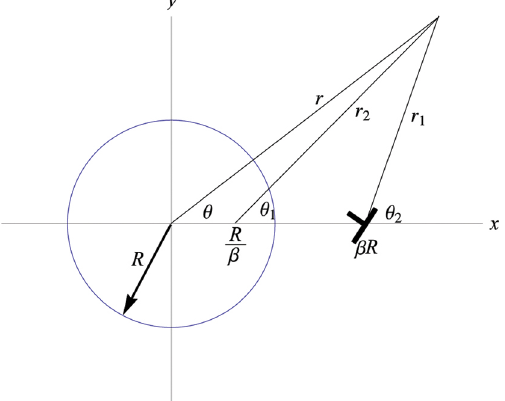
Figure 1: An edge dislocation near a circular void.